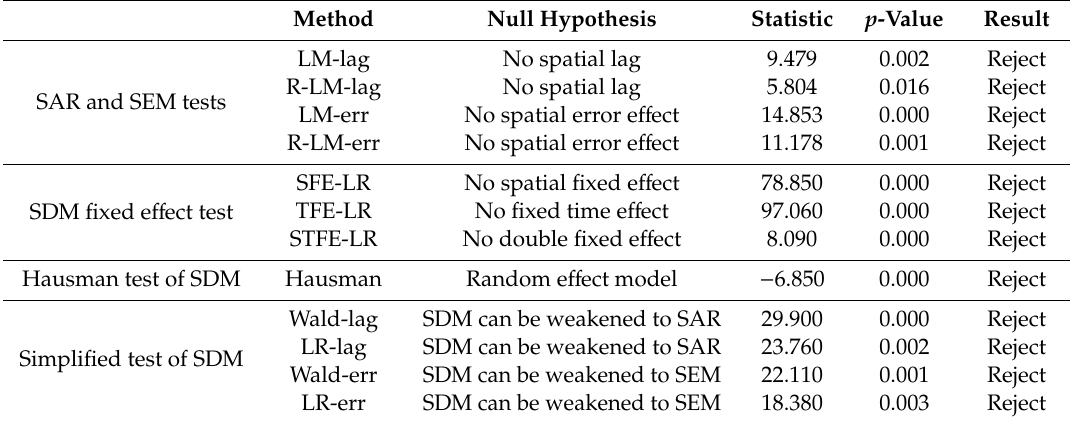
Table 6. Spatial panel data model test (GDP / SO 2 ) under the geospatial matrix.